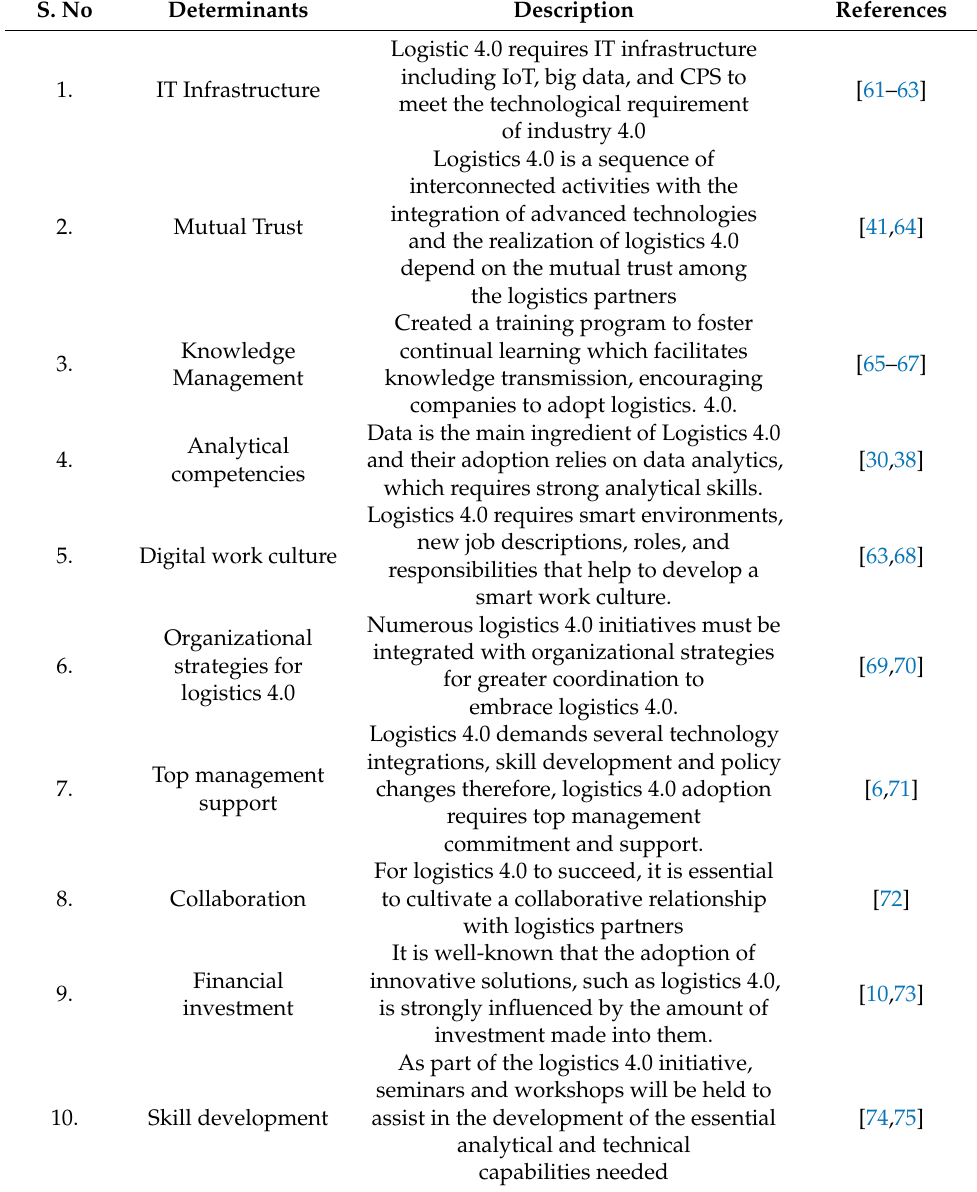
Table 1. Determinants of logistics 4.0